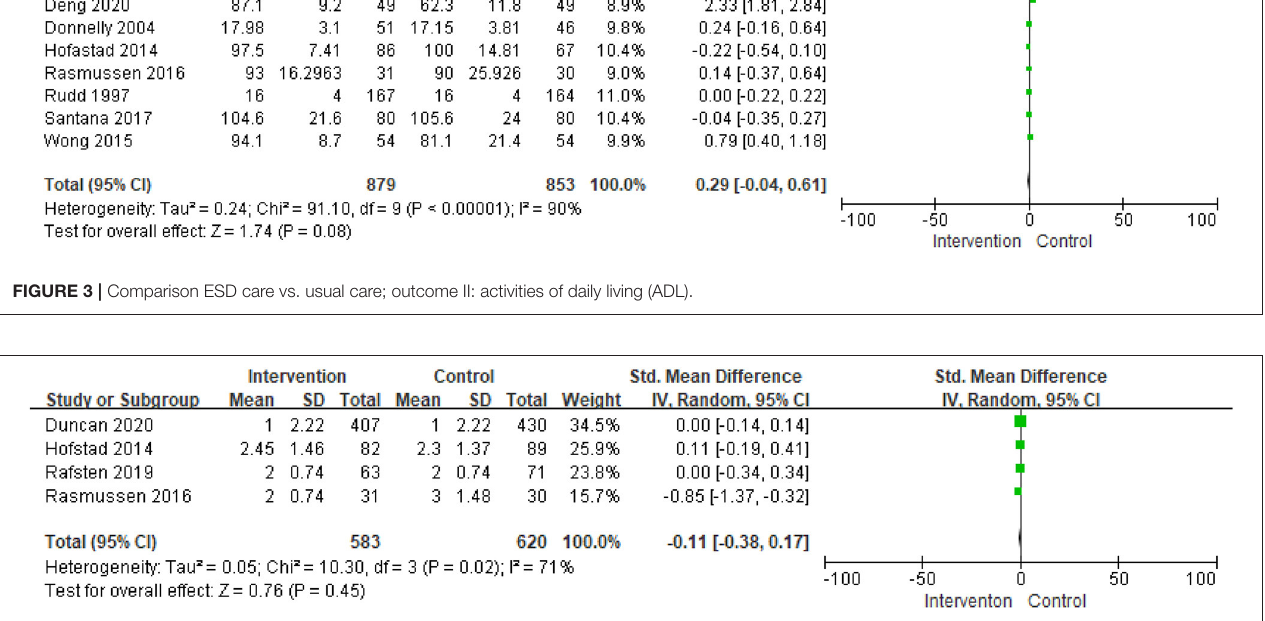
FIGURE 4 | Comparison ESD care vs. usual care; outcome III: modified Rankin scale (mRS).